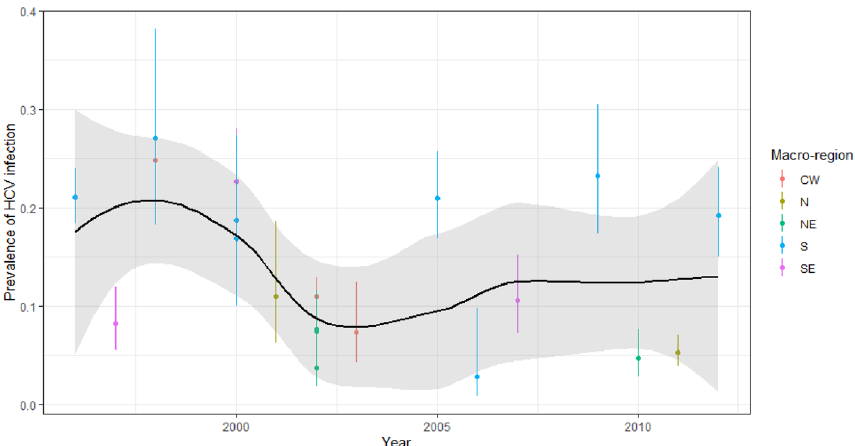
Figure 3. Prevalence rates for active HCV infection and 95% credibility intervals in haemodialysis patients in Brazil from 1996 to 2013 according to major geographic region of Brazil in which the studies were